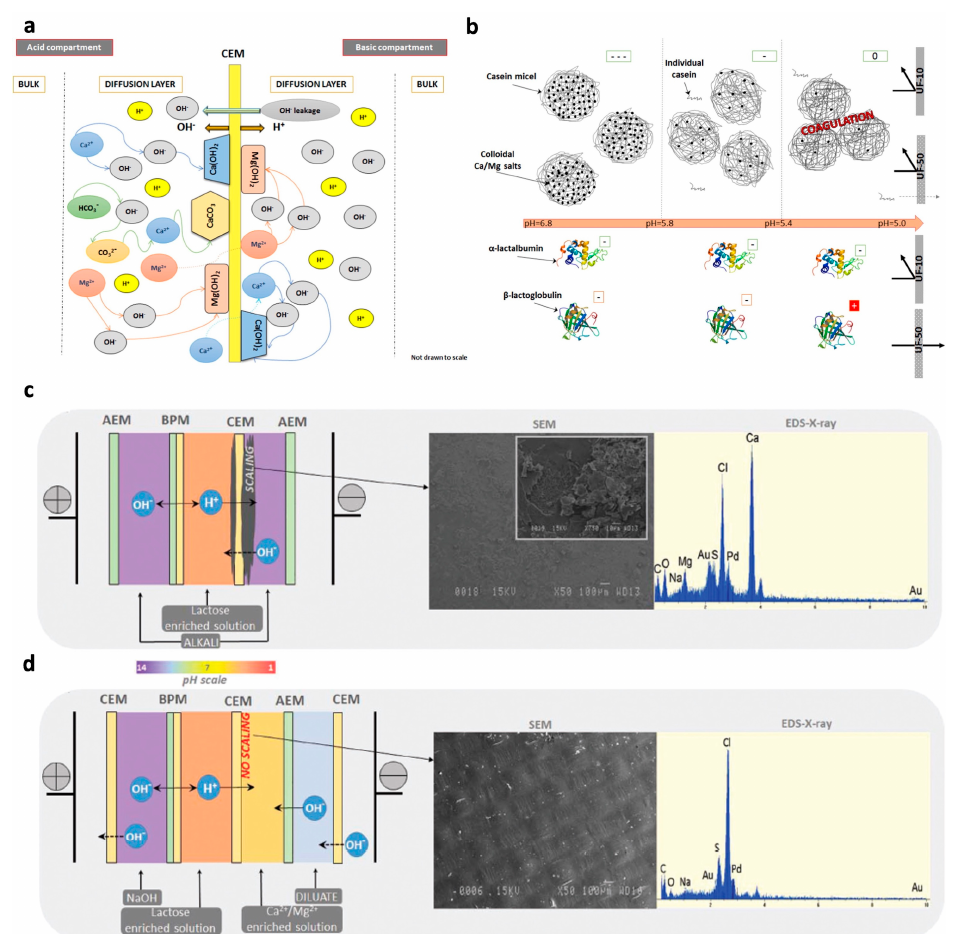
Figure 4. Scaling and fouling in EDUF during protein separation. ( a ) Mechanism of induction of major scaling agents: Ca(OH) 2 , CaCO 3 , and Mg(OH) 2 . ( b ) Plausible transport of casein, α -lactalbumin, and β -lactoglobulin in pH 6.8–5.0. Membrane with MWCO larger than 10 kDa is not recommended for this procedure since whey proteins and individual caseins may penetrate through the CEM and cause organic fouling. ( c ) Conventional five-compartments with represented scaling on CEM. ( d ) New 6-compartments without observed scaling on CEM. Panels ( a ) and ( b ) are reproduced from [117] with permission, © 2021 Elsevier Ltd. Panels ( c ) and ( d ) are reprinted from [81] with permission, © 2021 Royal Society of